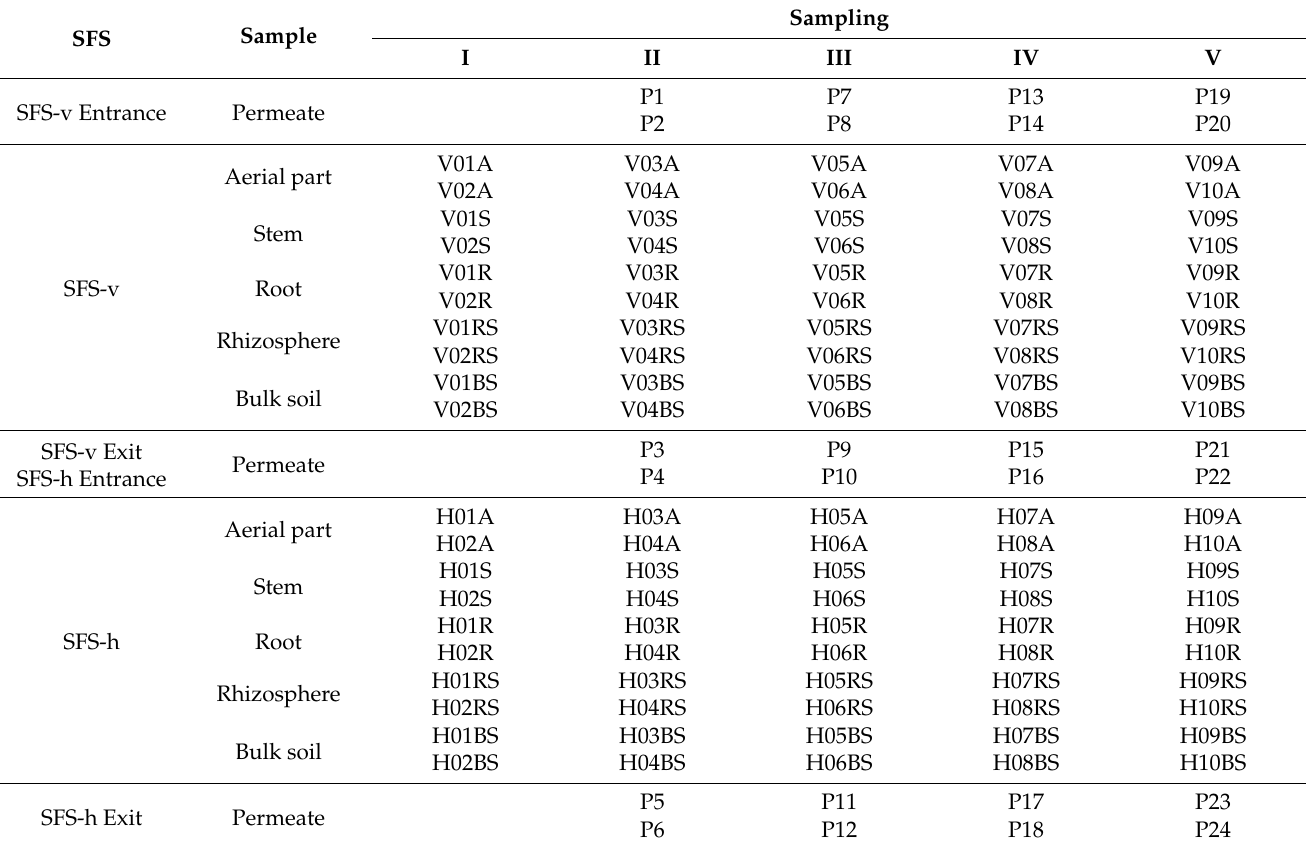
Table 1. Description of the samples collected in this work, and associated identification